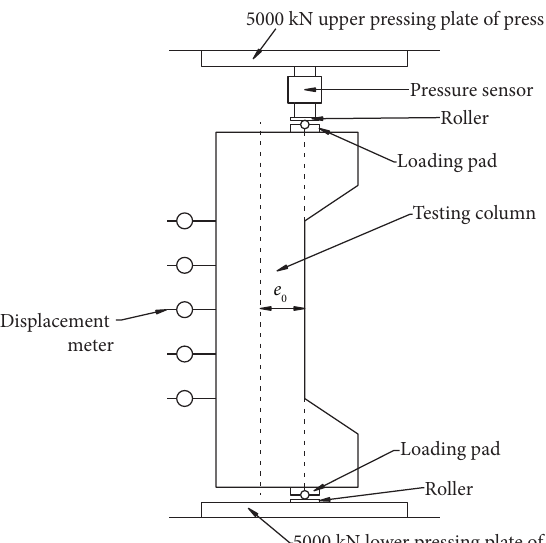
Figure 2: Experimental loading